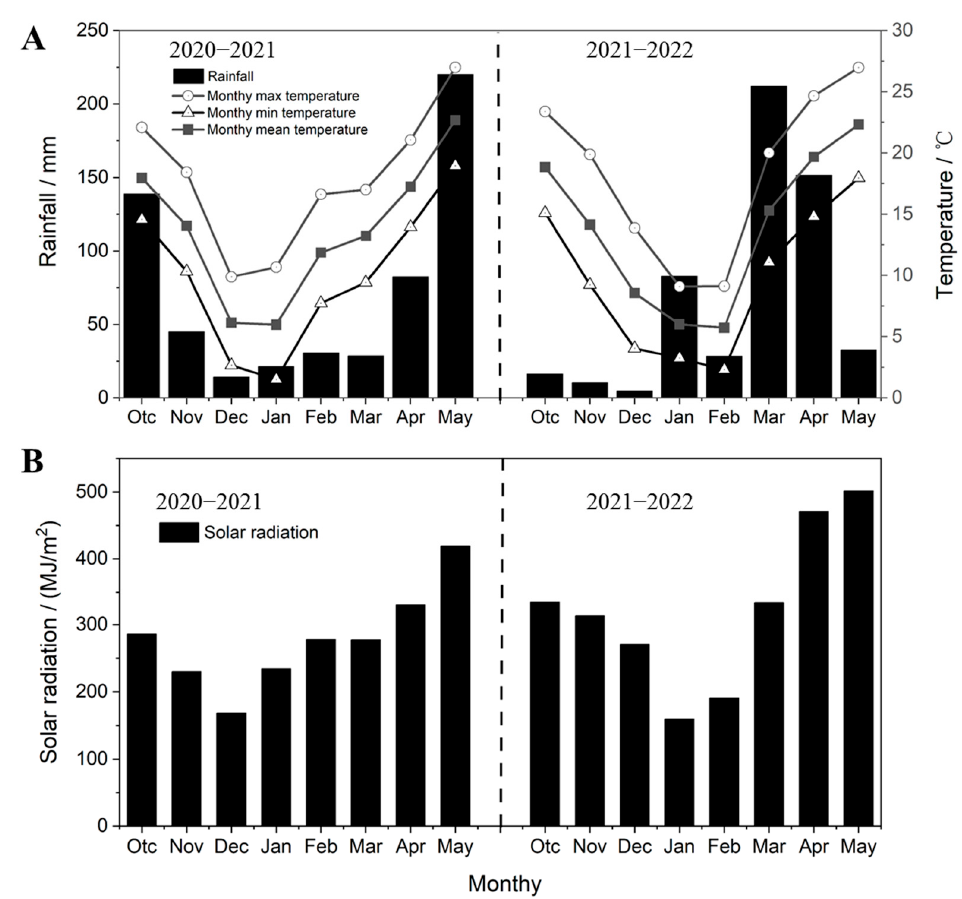
Figure 2. Climate data for the field during the two growing seasons. ( A ) Monthly rainfall and the monthly maximum, minimum, and mean temperature. ( B ) Monthly solar radiation.